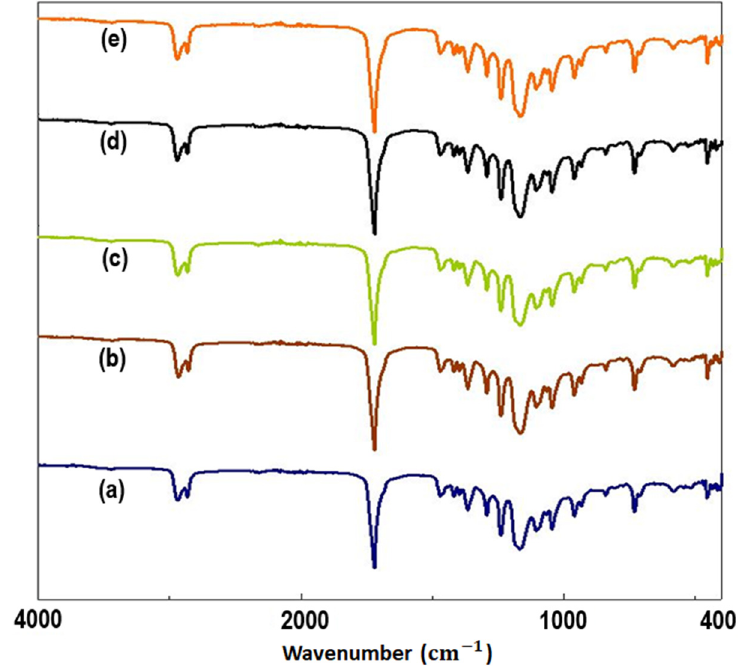
Figure 3. FTIR analysis spectra of 25% PCL ( a ), 25% PCL/0.1% BFO ( b ), 25% PCL/0.1% BFO/1Q ( c ), 25% PCL/0.1% BFO/3Q ( d ) and 25% PCL/0.1% BFO/5Q ( e ) microfibrous